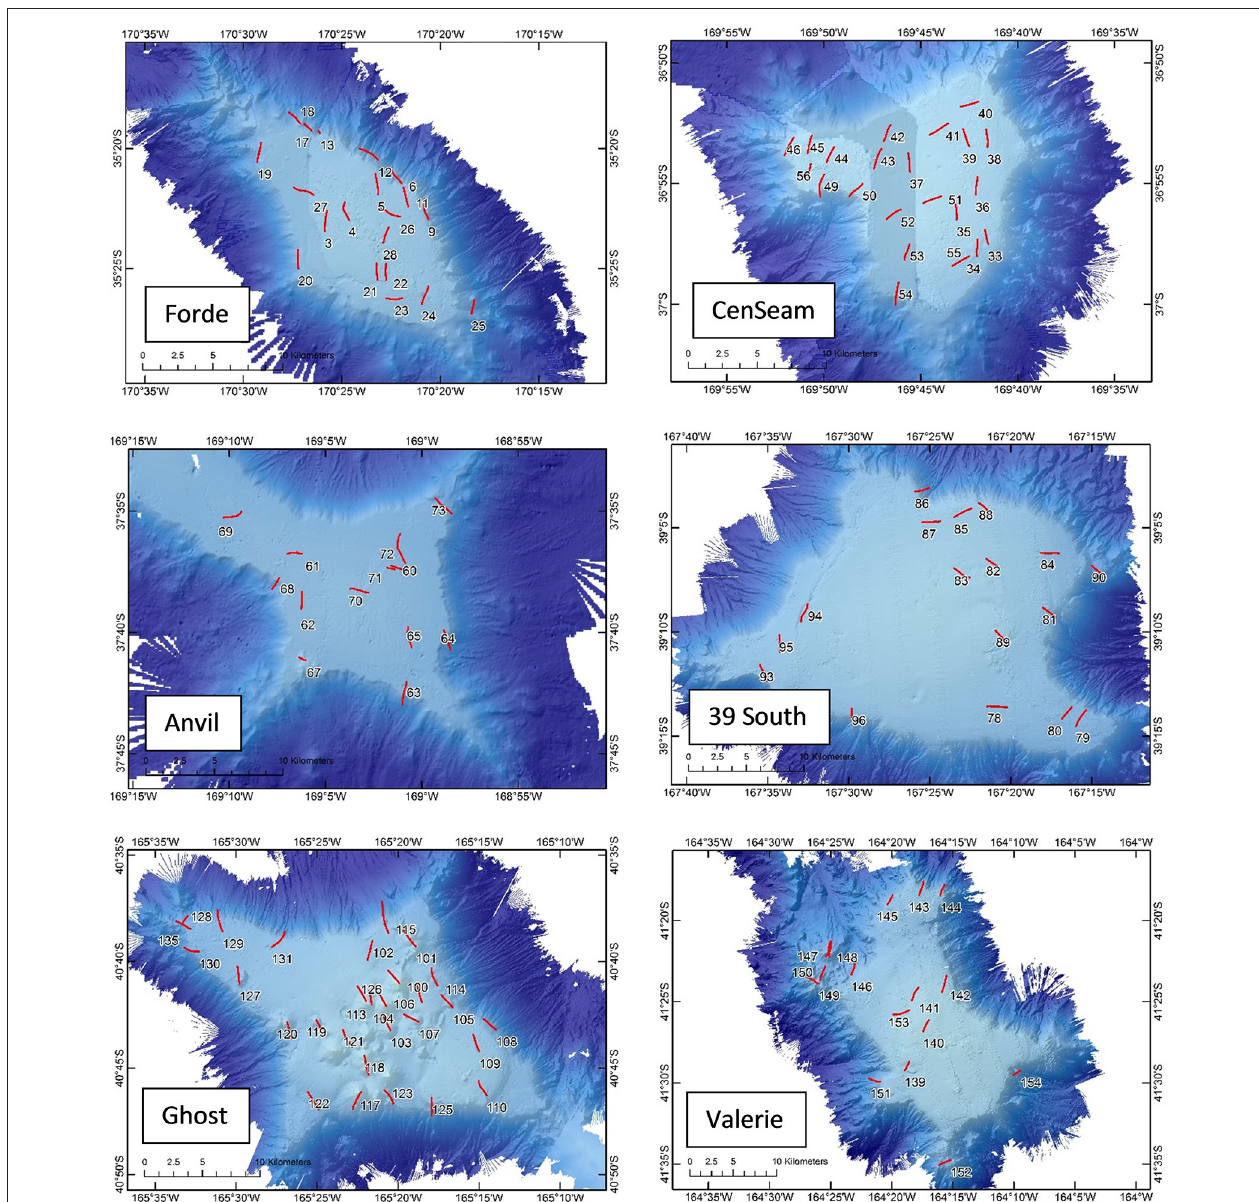
FIGURE 2 | Bathymetric maps showing the position of photographic transects on each of the study seamounts (number = station number). JCM seamount is not shown because it was only partially surveyed and only one photographic transect was completed.